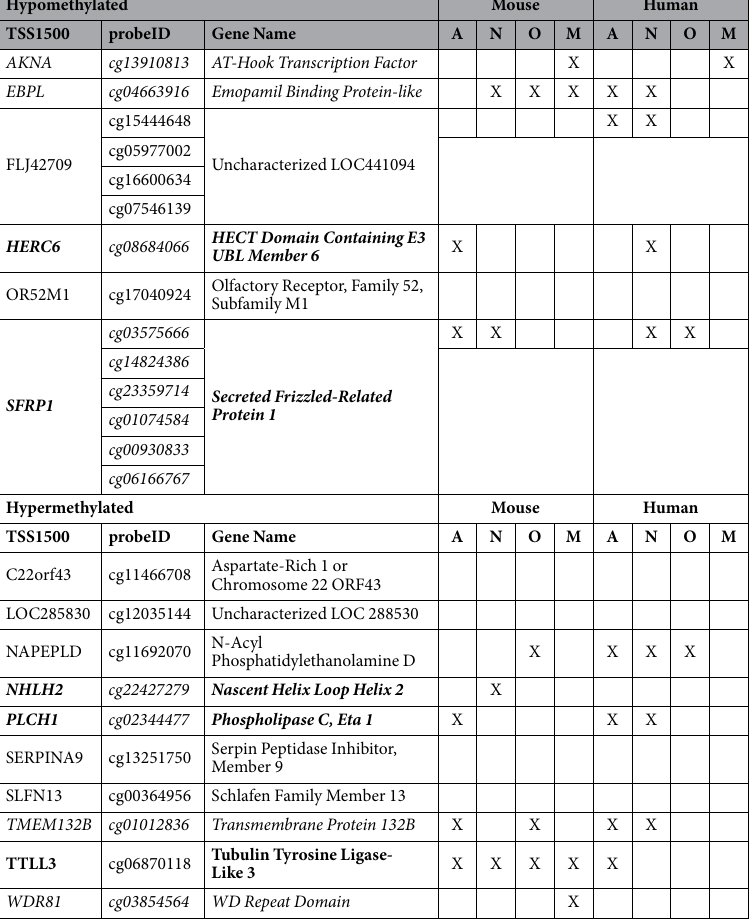
The presence/loss of methylation within the TSS alters mRNA levels of the target genes. We identified 6 genes where demyelination led to decreased methylation. Among these, mRNA levels of AKNA were significantly increased following demyelination. AKNA is a major regulator of CD40 and CD40 ligand 30 and is reported in RNA seq databases to be expressed by microglia/macrophage cells (Table 3) in both mouse and human. Increases in microglial CD40 expression and interactions with its ligand CD40L have been shown to induce/stimulate the expression of tumor necrosis factor-alpha (TNF- α ) and to initiate neuronal death 31 . Following demyelination, we detected a significant increase in methylation within the TSS of WDR81, a gene involved in neuronal survival 32 . Increased levels of AKNA in conjunction with decreased WDR81 following demyelination could therefore lead to increased levels of TNF- α and neuronal injury. In addition, we also identified hypomethylation and a significant increase in mRNA levels of SFRP1 following demyelination. SFRP1 is an inhibitor of the WNT signaling proteins, which regulate learning and memory as well as synaptic plasticity at central synapses 33, 34 . Our comparative methyl- ation analysis also identified hypermethylation (near the TSS) and decreased mRNA levels of NHLH2 and PLCH1 (Fig. 4). NHLH2 is a positive regulator of melanocortin receptors and modulates memory and learning 35, 36 , while PLCH1 loss is generally associated with impaired working memory 37 . Differential methylation and con- comitant increased levels of SFRP1 as well as decreased NHLH2 and PLCH1 could therefore lead to the decreased synaptic density and memory performance that have been previously reported following demyelination 5, 20 . The ongoing discovery of epigenetic factors underlying pathogenesis in MS is substantial 14 . These factors are relatively easily modifiable, in many cases utilizing readily available pharmacological agents targeting epige- netic modifiers. The study of DNA methylation in MS pathogenesis has been largely limited to comparisons of either the MHC or the human leukocyte antigen (HLA-DRB1 region) were identified in a comparison between CD4 + T cells from patients with MS and healthy individuals 39 . In addition, significant differences in the meth-